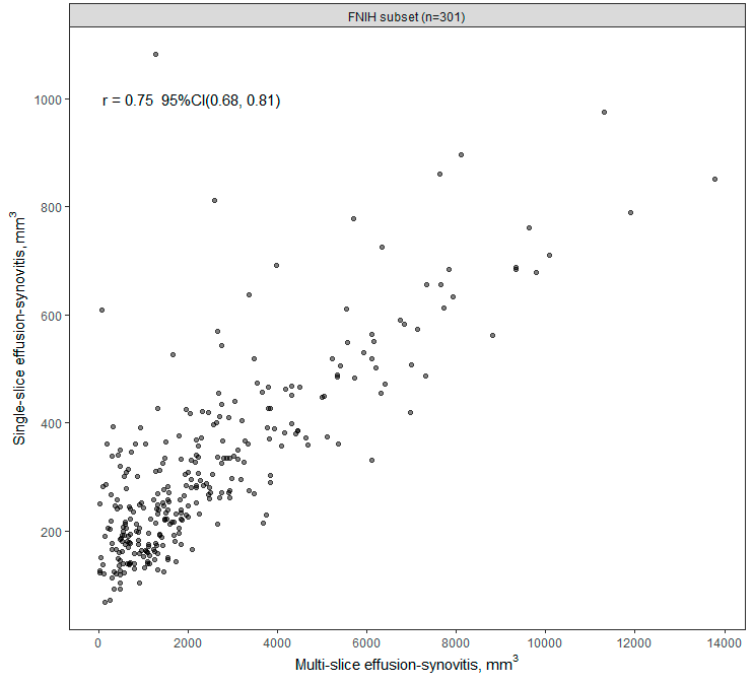
Figure 4. Single-slice vs. multi-slice effusion-synovitis volume (FNIH, n = 301).